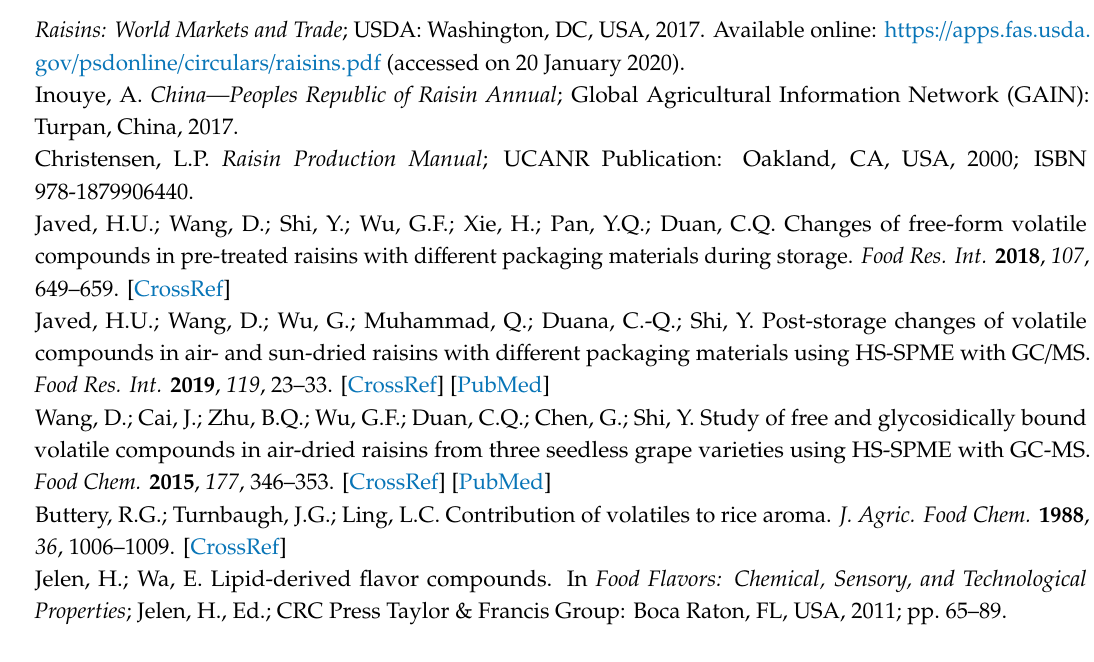
Supplementary Materials: The following are available online: Figure S1: E ff ect of drying method on TSS, pH and moisture content of stored raisins, Table S1: E ff ect of drying methods on UFAO-derived compounds of Thompson Seedless raisins during